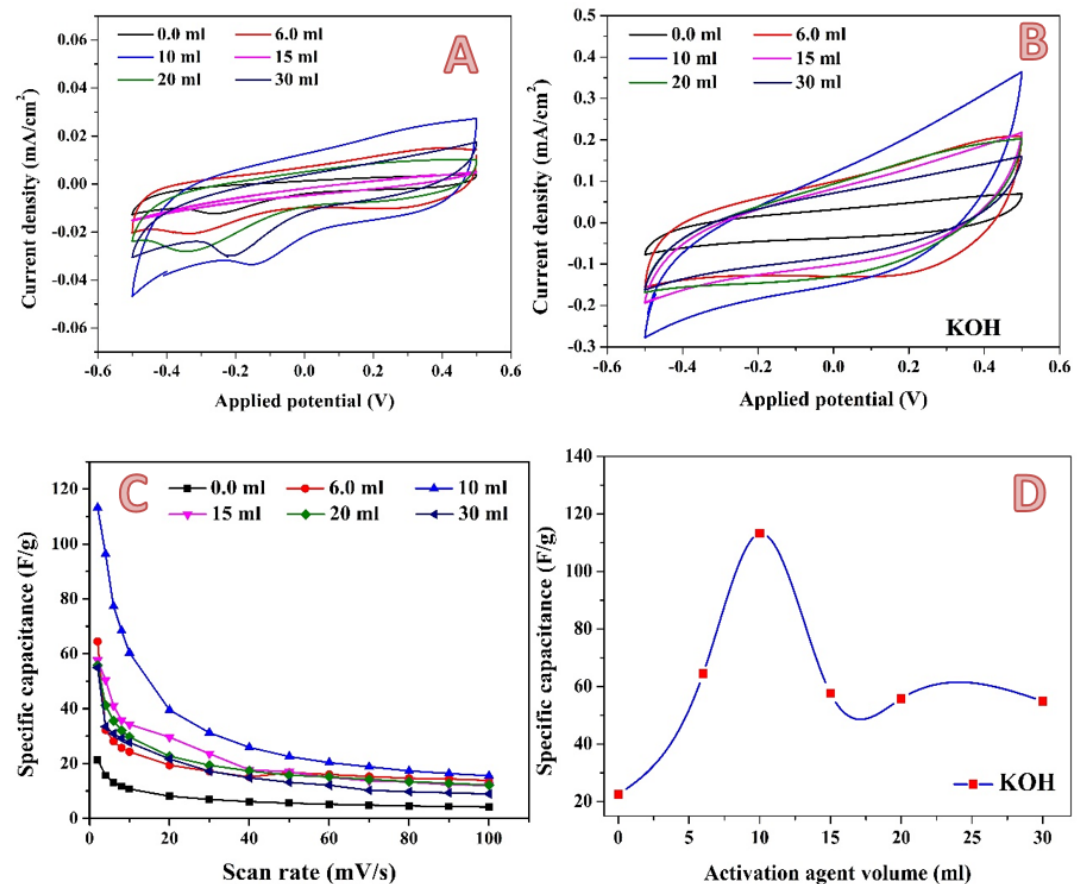
Figure 9. Cyclic voltammograms in the presence of 0.1 M H 2 SO 4 electrolyte at a scan rate of 2 mV; ( A ) and 100 mV/s; ( B ) for the 0.3 g activated carbon obtained from rice husk using different volumes of 3.0 M KOH solution. Influence of the scan rate on the specific capacitance; ( C ) and the effect of the alkaline solution volume on the specific capacitance (at 2 mV/s); ( D ).